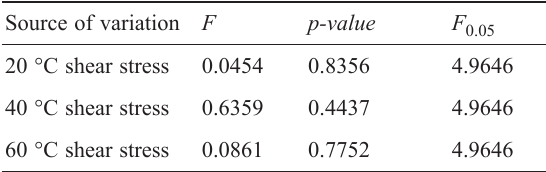
Table 7. ANOVA for shear stress from field test and model equation Source of variation F